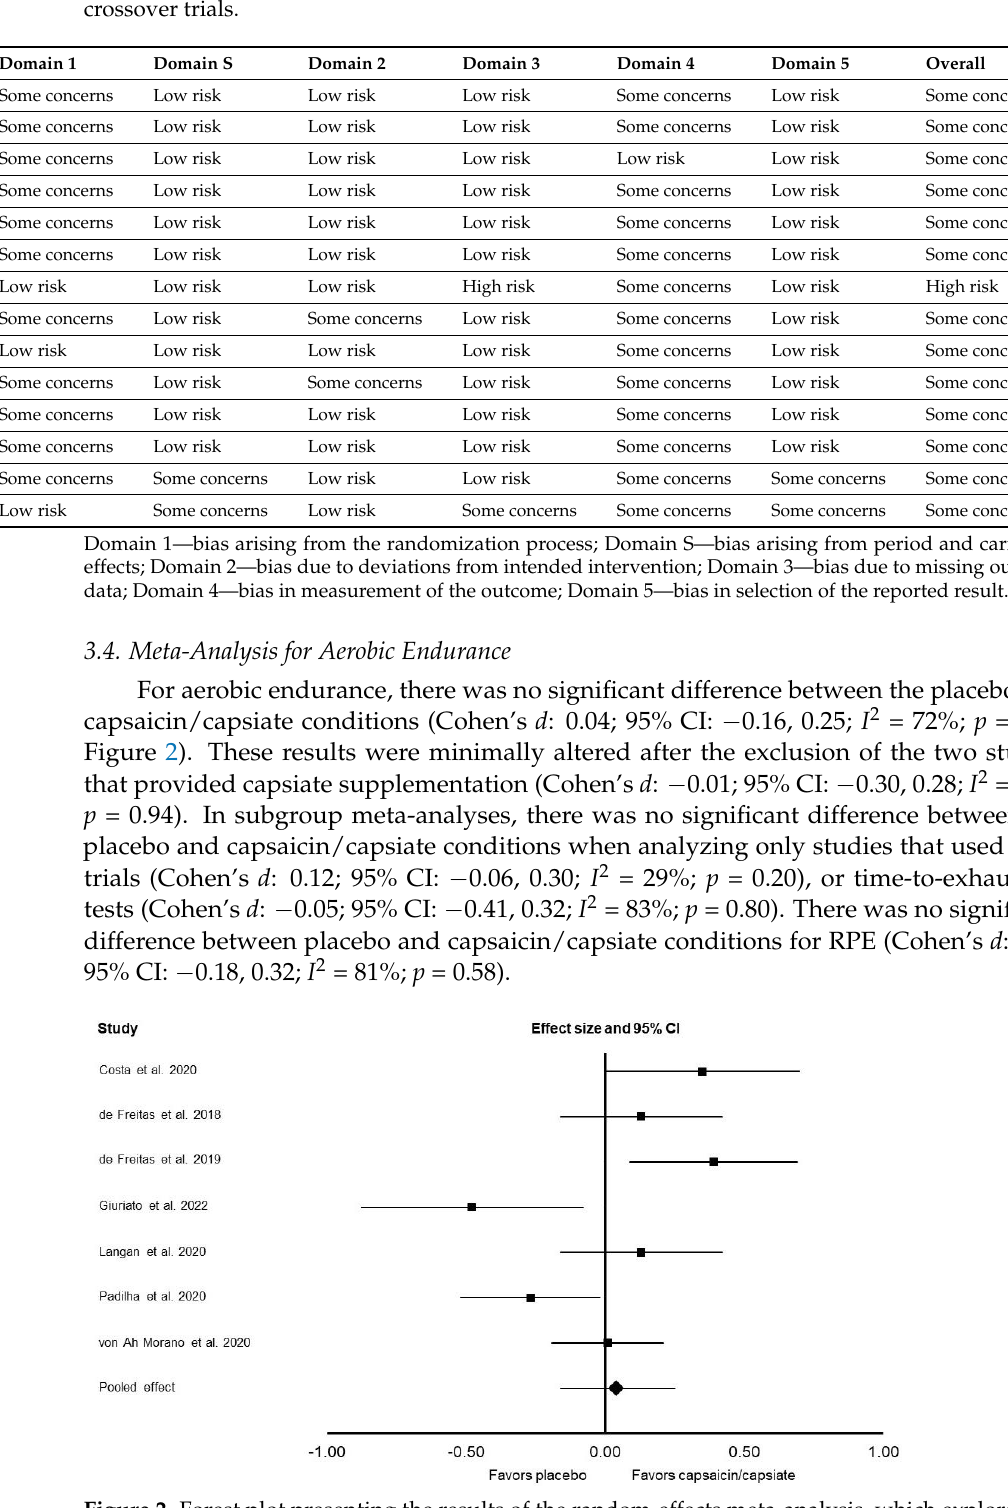
Figure 2. Forest plot presenting the results of the random-effects meta-analysis, which explored the effects of capsaicin/capsiate vs. placebo on aerobic endurance. Data are presented as effect sizes (Cohen’s d ) and 95% confidence interval (CI). The diamond at the bottom presents the overall effect. The plotted squares denote effect sizes, and the whiskers denote their 95% CIs. The analysis is based on seven included studies [12,15,16,19,21,22,25].